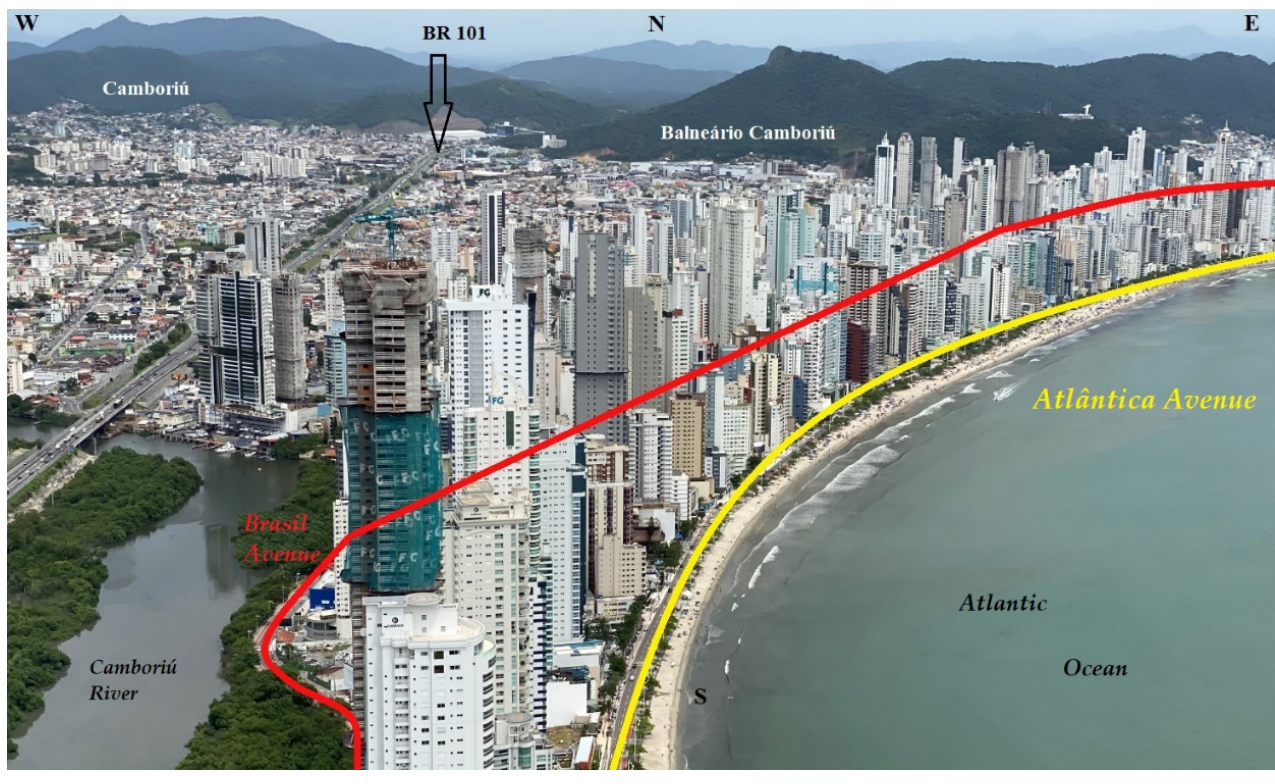
Figure 7. Sketch of the mobile transects in waterfront of Balneário Camboriú/SC. Source: Authors, taken during fieldwork, August 2019.